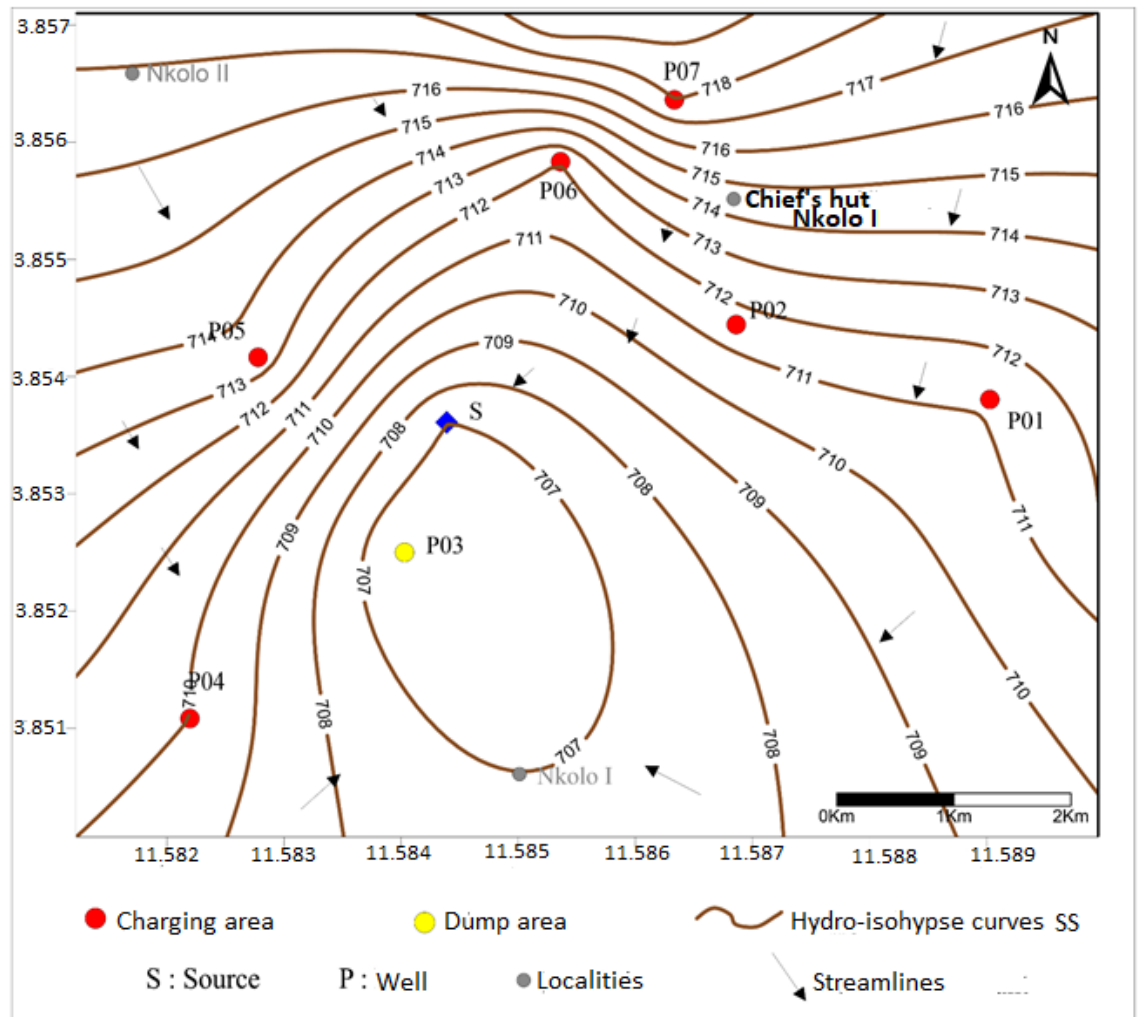
Figure 4. Minimum piezometric map (dry season) of the Nkoabang aquifer. (P1): Nkolo I; (P2): Nkolo II (near the solidarity health centre); (P3): at the Etambè primary school; (P4): Etambè Catholic church; (P5): Nkolo I (near to the chief’s hut); and (P6 and P7): Nkolo I (near the fountain). The amplitude of variation of the piezometric level in the study area is between 0.4 and 3.3 m for an average of 1.19 ± 1 m. These results are comparable to those obtained by Feumba [4] (between 0.55 m and 1.65 m) in the watershed of Ekozoa, by Kalla Mpako [6] in the watershed of Ntem (between 0.1 m and 1.91 m), by Mfokapour é Chintouo [13] in the Odza watershed (between 0.15 m and 3.44 m), by Eyong Jean-Baptiste [46] in the Ak é e watershed (0.14 m and 0.97 m with an average value of 0.34 m), by Bon [47] in the Olezoa watershed, and by Sendjoun [48] in the Messamendongo area and its surroundings (0.05–4.56 m). This work indicates that piezometric fluctuations are linked to rainfall and